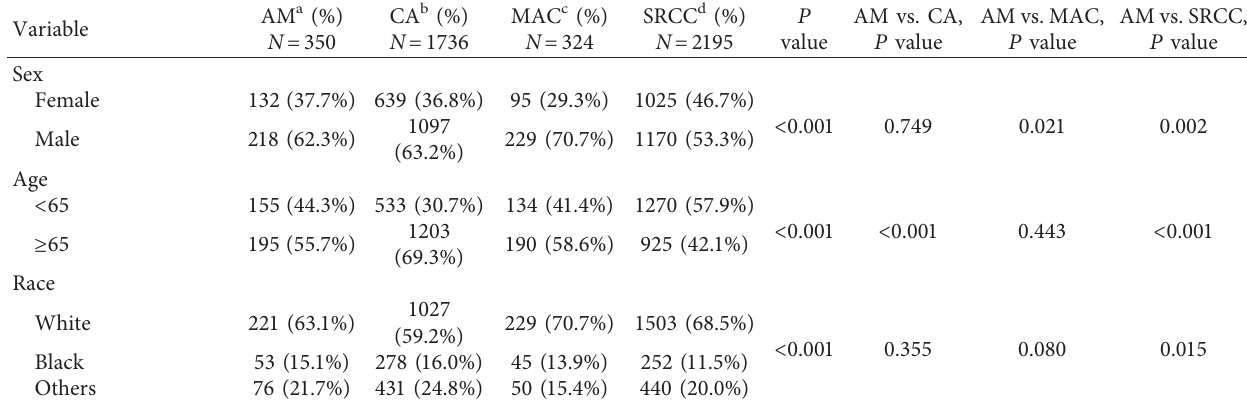
Table 2: Comparisons of the clinicopathologic features between adenocarcinoma with mixed subtypes and other histologic types, including classical adenocarcinoma, mucinous adenocarcinoma, and signet-ring cell carcinoma in advanced gastric